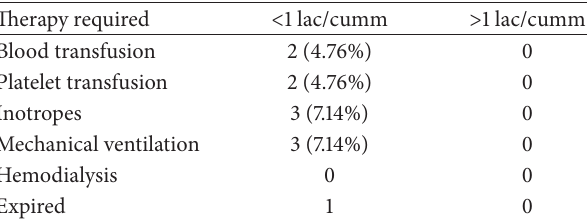
Table 4: Comparison of therapy required in the two